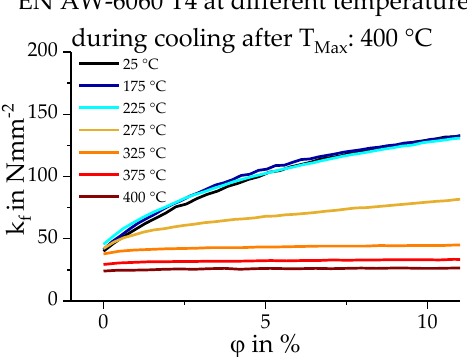
Figure 9. Experimentally obtained flow curves of EN AW-6060 T4 alloy at different temperatures during cooling after the 400 ◦ C maximum temperature, phase (B). Metals 2019 , 9 , x FOR PEER REVIEW